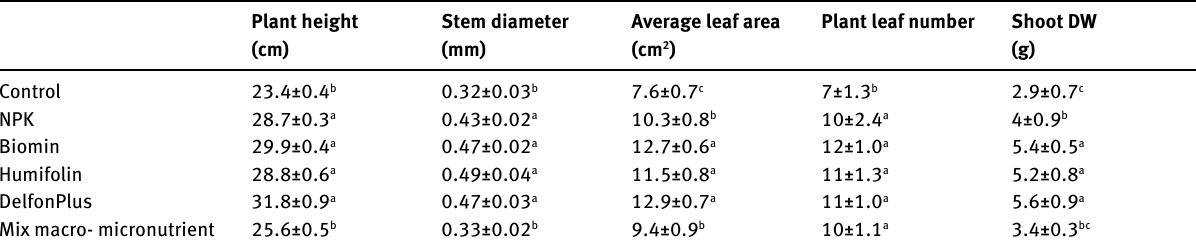
Table 3: Mean values (± SD) of growth parameters of green bean plants treated with foliar applications of different organic chelates, a mix of nutrients and soil applied NPK under greenhouse conditions. In each column, means with at least one common letter are not significantly different (P=0.05)